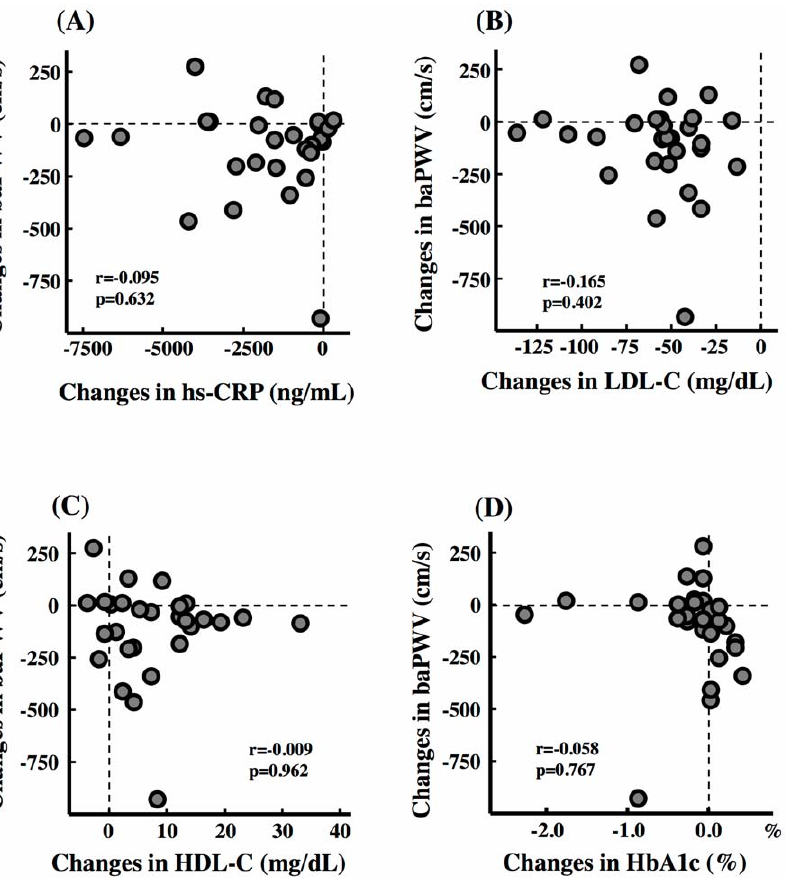
Figure 3. Association Between Arterial Wall Stiffness and Other Parameters. Correlations between changes in brachial and ankle pulse wave velocity (baPWV) and (A) high-sensitivity c-reactive protein (hs-CRP), (B) low-density lipoprotein cholesterol (LDL-C), (C) high-density lipoprotein cholesterol (HDL-C) and (D) hemoglobin A1c (HbA1c).